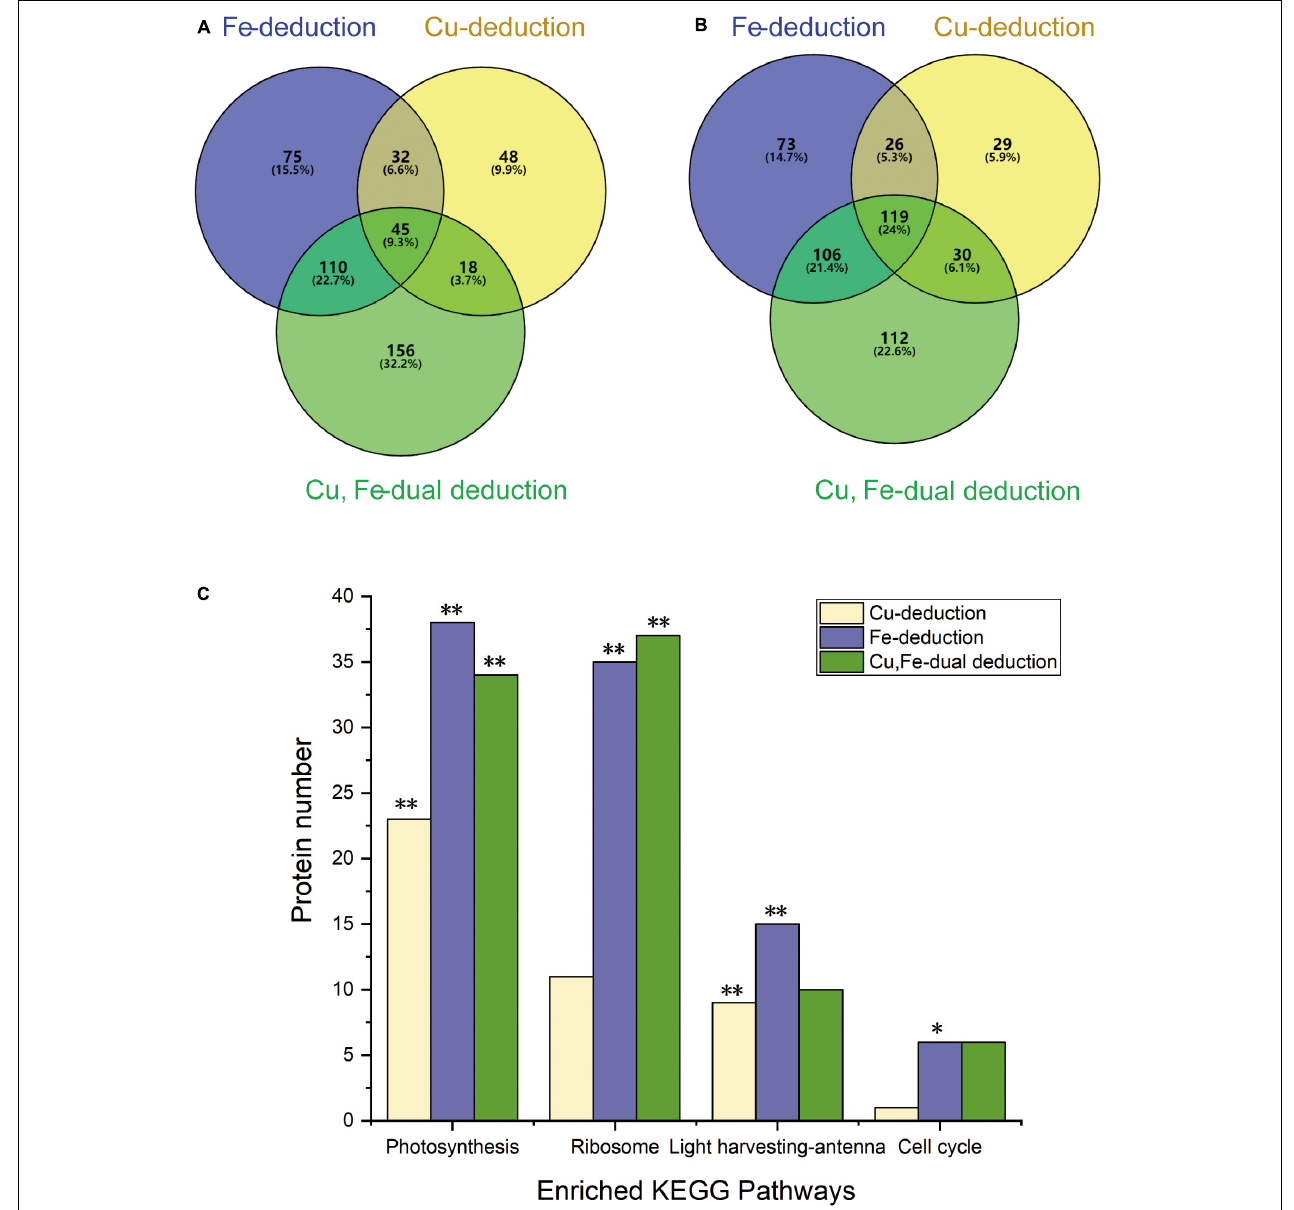
FIGURE 3 | Venn diagrams showing differential protein abundances and enriched KEGG pathways. (A) Up-regulated proteins ( ≥ 1.2-fold); (B) down-regulated proteins ( ≤ 0.83-fold); (C) ** P < 0.01, * P <